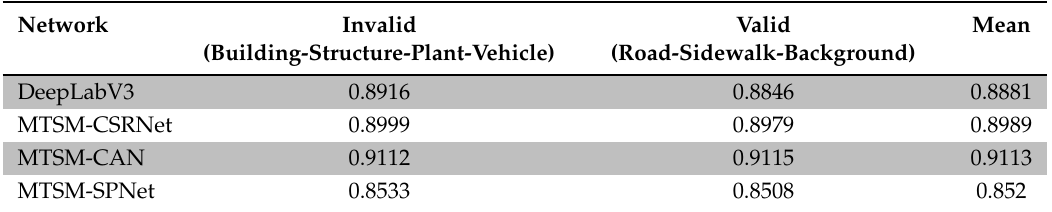
Table 3. Valid–invalid IoUs and their means for DeepLabv3 and our MTSM models trained on